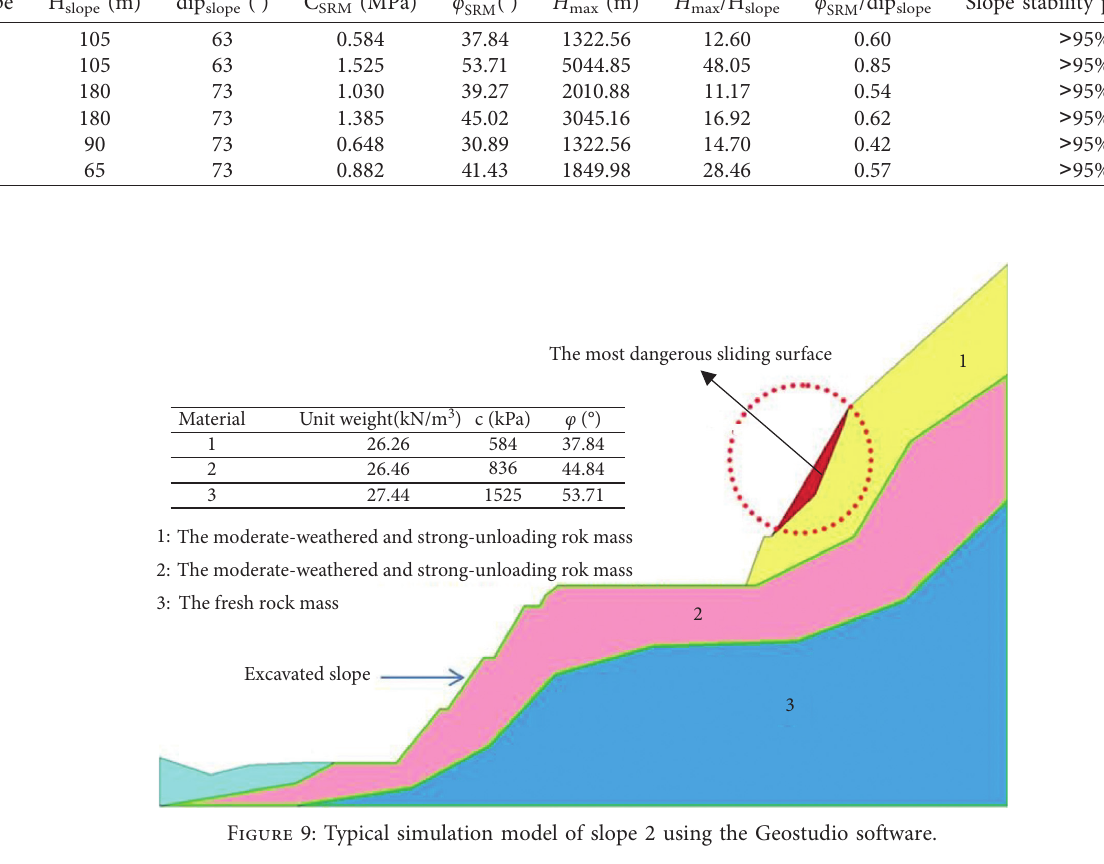
Table 5: Summary of the orientation-independent stability probability at the investigated slopes. Slope H slope (m)